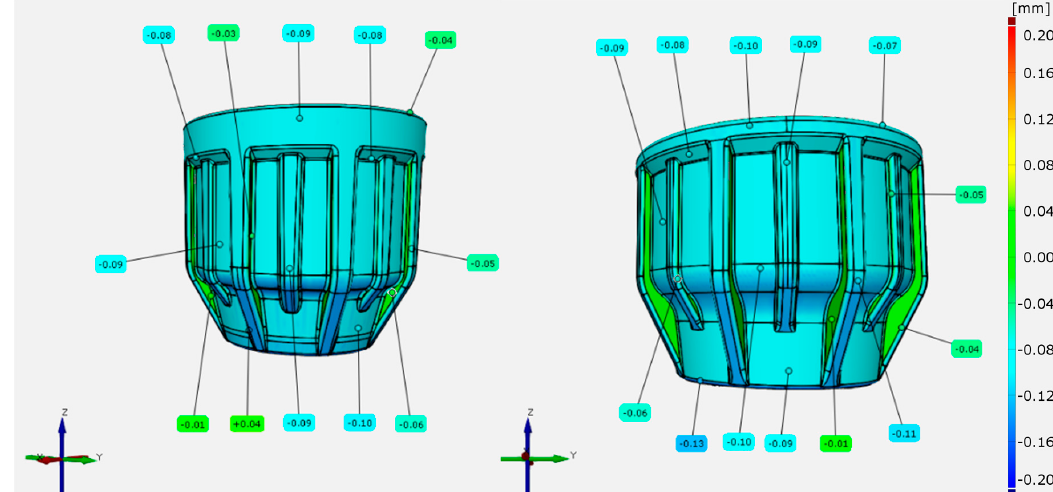
Figure 14. Shape accuracy results of the fabricated injection-moulded cap measured with the aid of a RangeVision Spectrum 3D Scanning device compared to the target CAD geometry proving the high precision when using conformal cooling (left). Final FE-simulated shrunk cap shape after cooling down compared to the target CAD geometry (right) proving similar shape deviation on the outer cap skin.